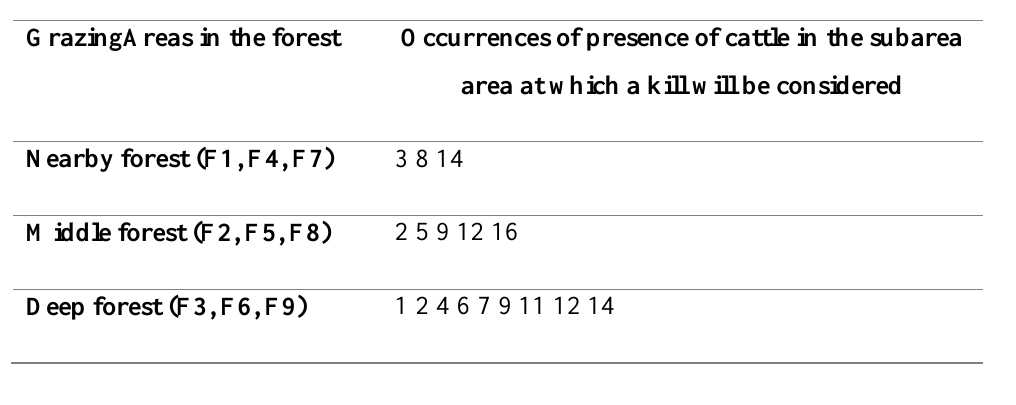
Table 2. Predefined timing for cattle predation by